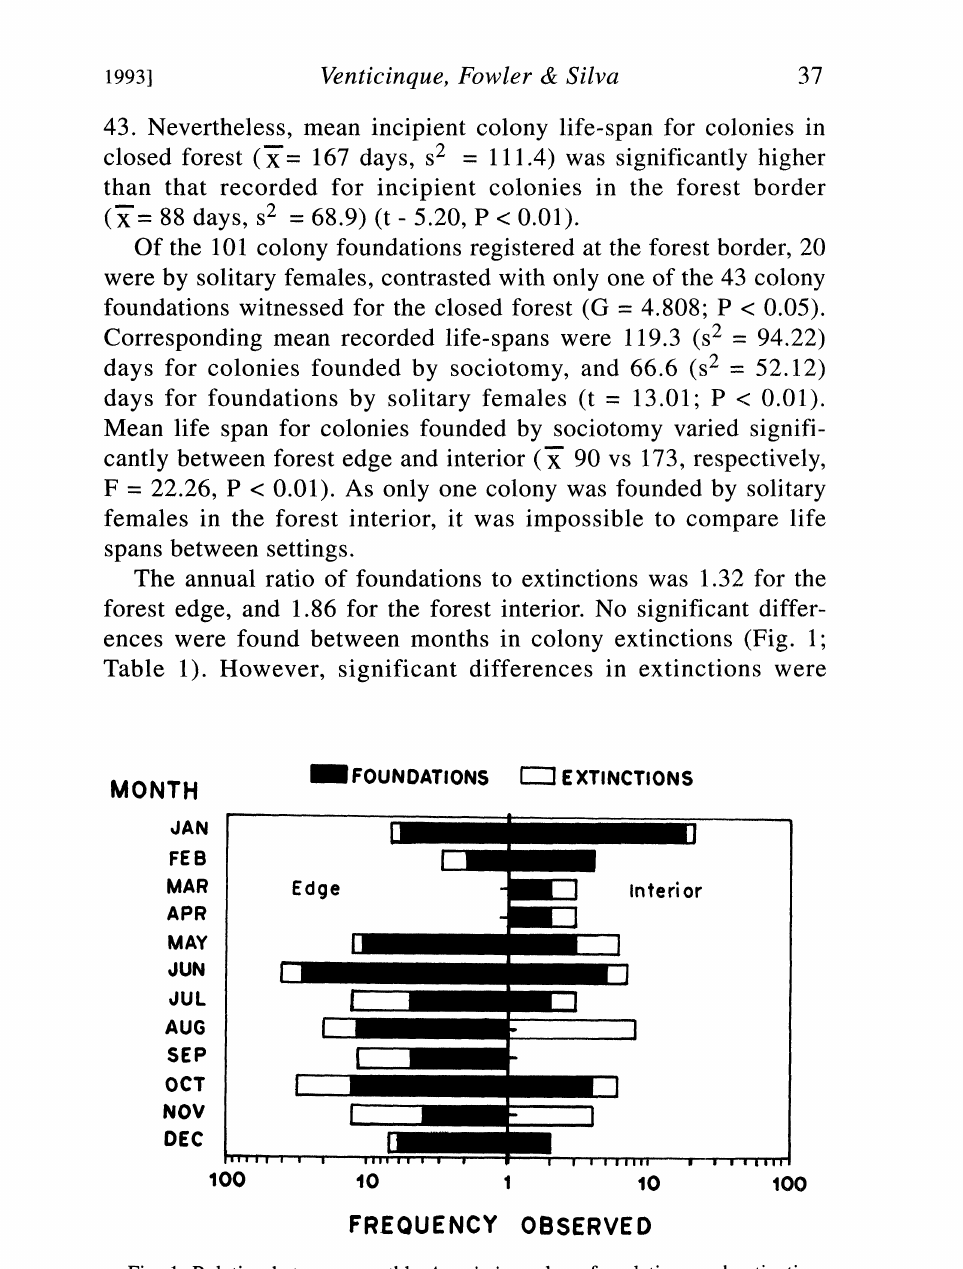
Fig. 1. Relation between monthly A. eximius colony foundations and extinctions in Amazonian forest edges and forest